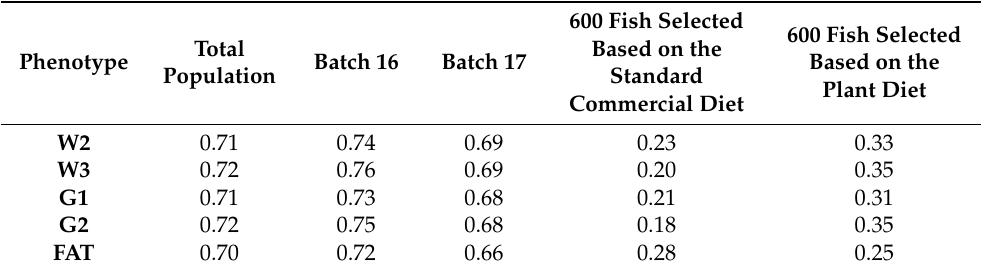
Table 7. Ranking (Spearman’s) correlation between the breeding values (EBV) for the studied traits under different diets for all the selection candidates and the selected 600 fish for